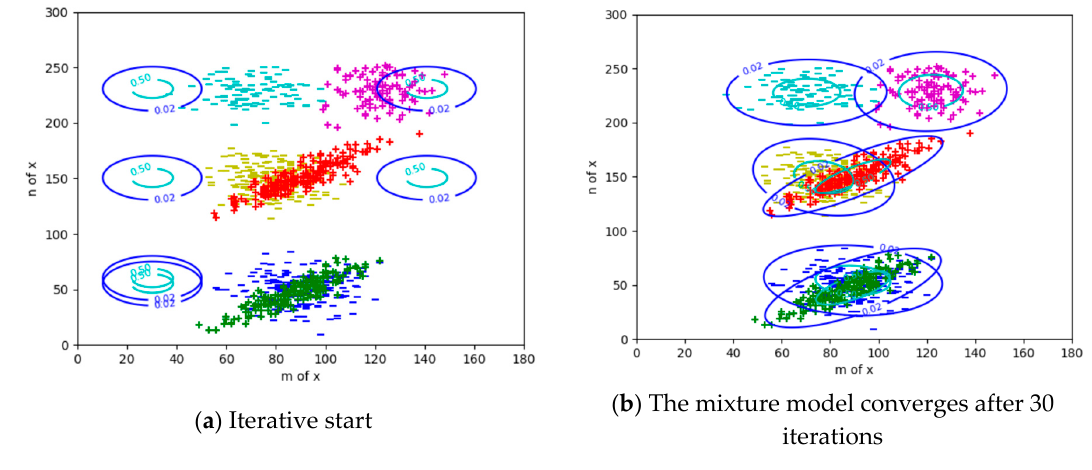
Figure 15. CM4 for a two-dimensional mixture model. There are six components with Gaussian